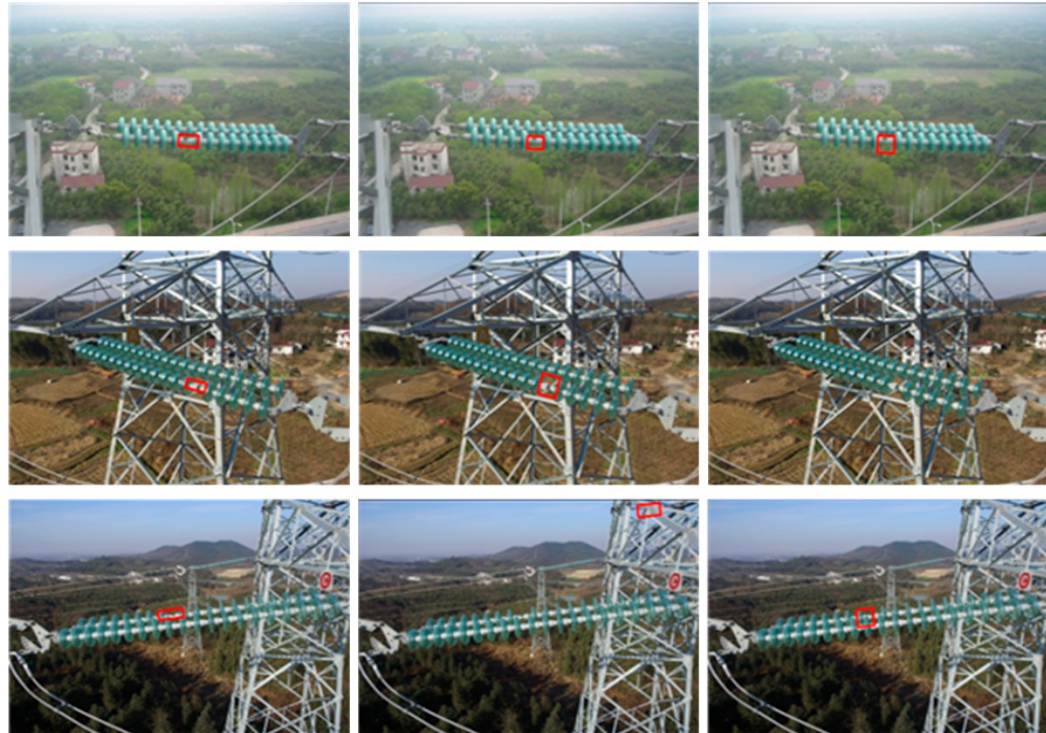
Figure 9. Experimental results in aerial images with insulator one fault. In each row, the first column to the third column depicts the performance of the proposed method, method [20], and method [11], respectively.